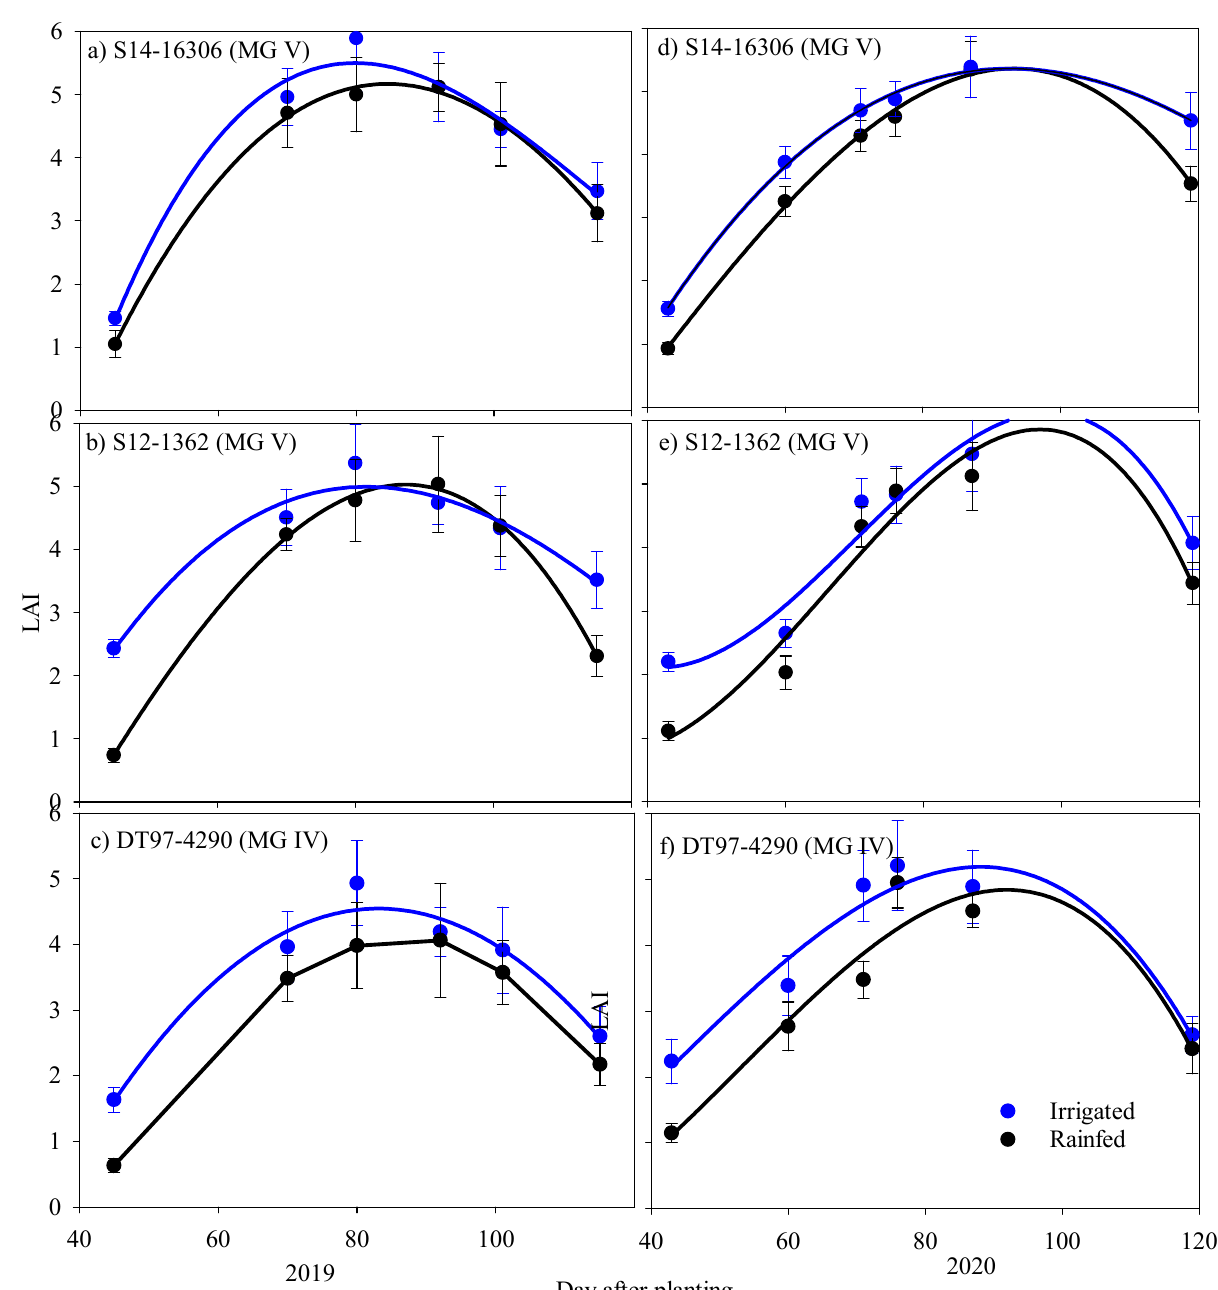
Figure 2. Leaf area index variability in the three cultivars viz., S14-16306, S12-1362, and DT97-4290 in rainfed and irrigated conditions during 2019 and 2020. Each data point represents five readings and three replications. A global curve was fitted to the measured LAI using Sigma Plot v14.